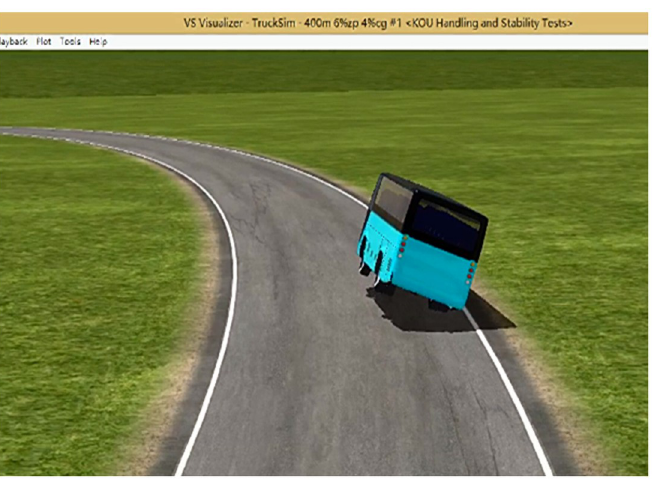
Fig 15. Critical state of large bus rollover.